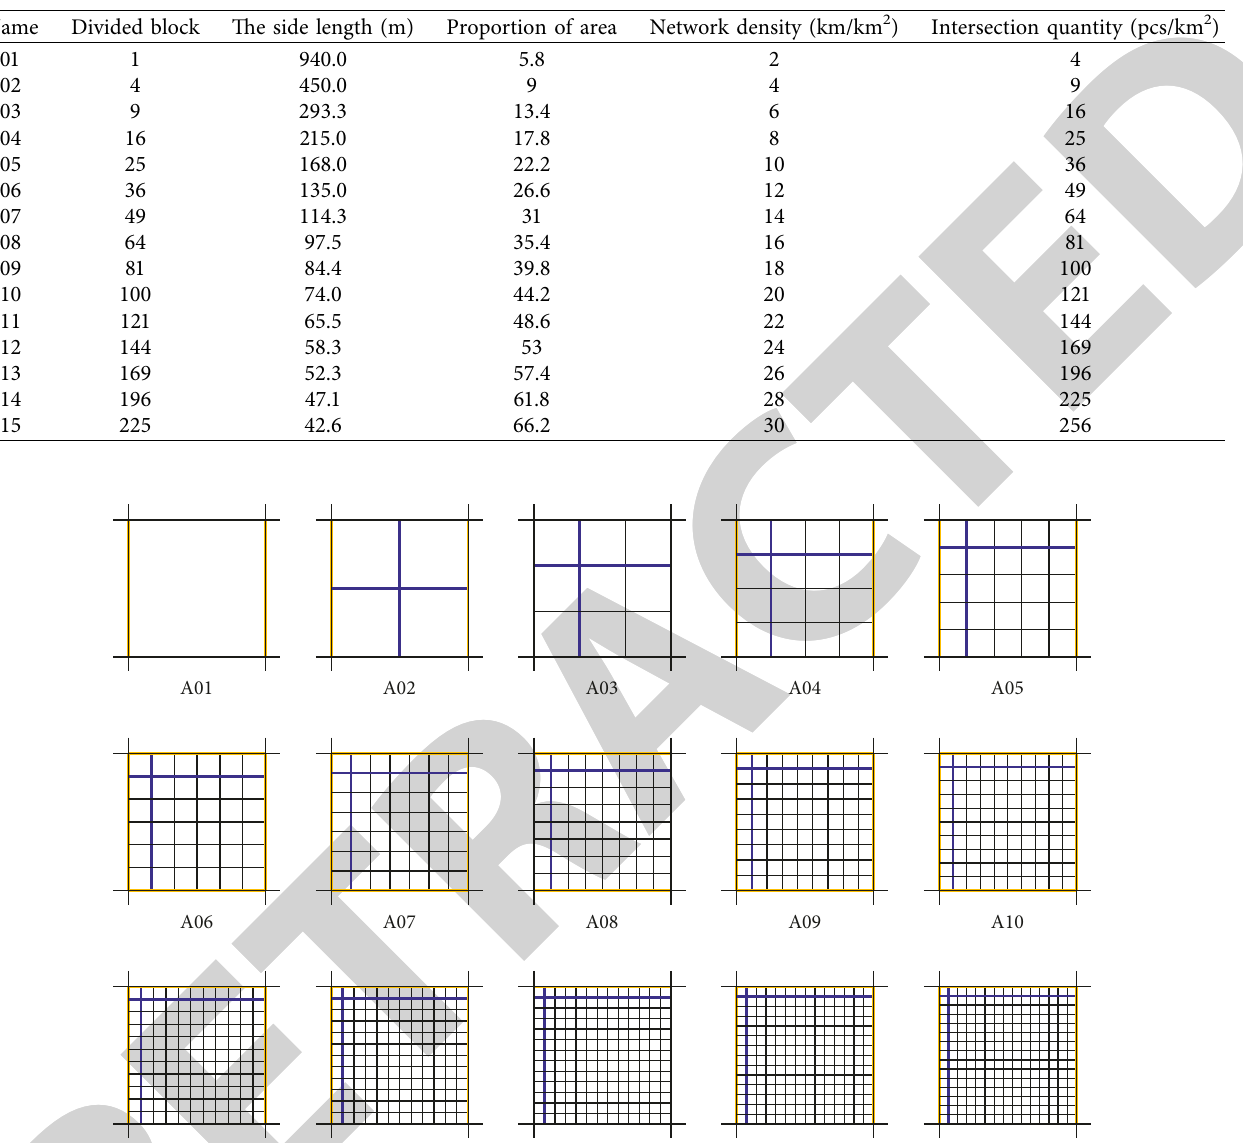
Figure 8: Fifteen types of road network structure continuously set by the square block model.